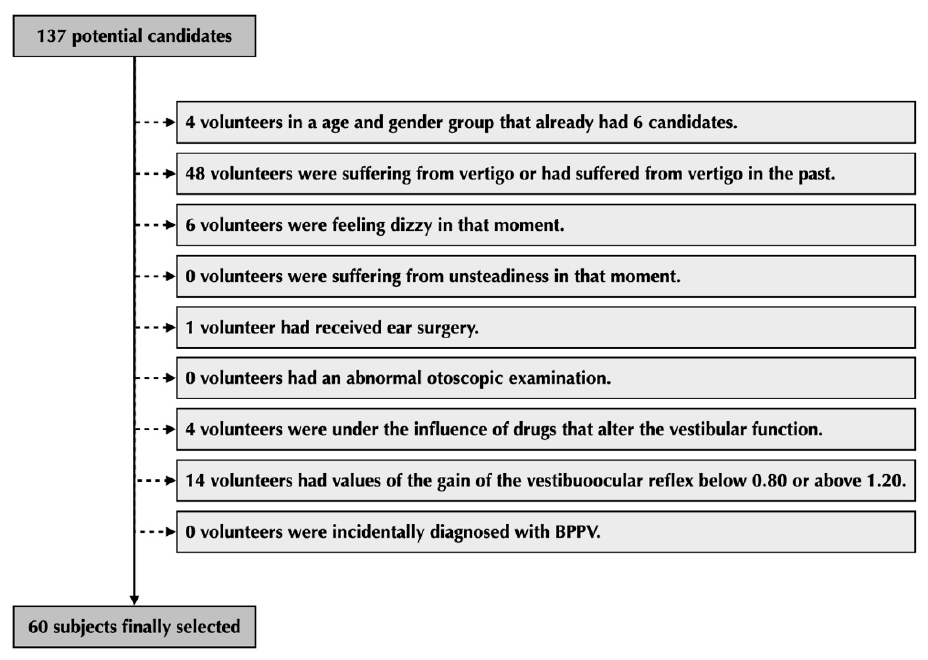
Figure 3. Algorithm used to select the 60 patients that were part of the final sample.